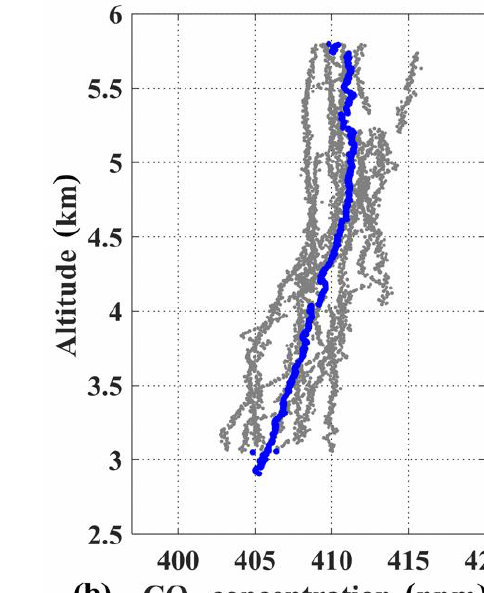
Figure 7. The concentrations of CO 2 measured by the UGGA before calibration ( a ) and the concen- trations of CO 2 measured by the UGGA after calibration ( b ). The black straight line is the concen- tration value of the standard gas.